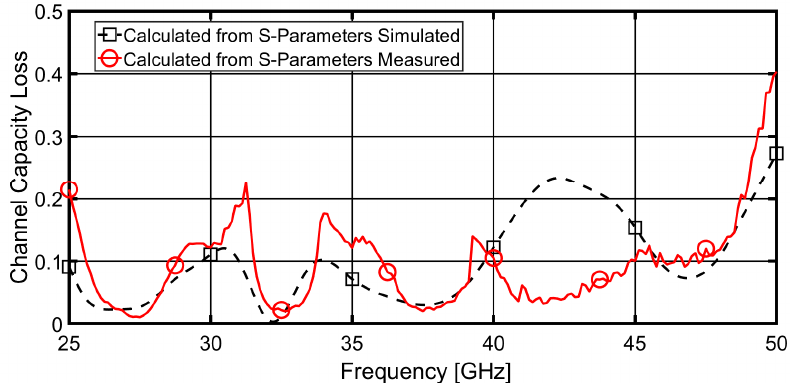
Figure 9. CCL of the proposed four-element MIMO antenna between port 1 and 2.